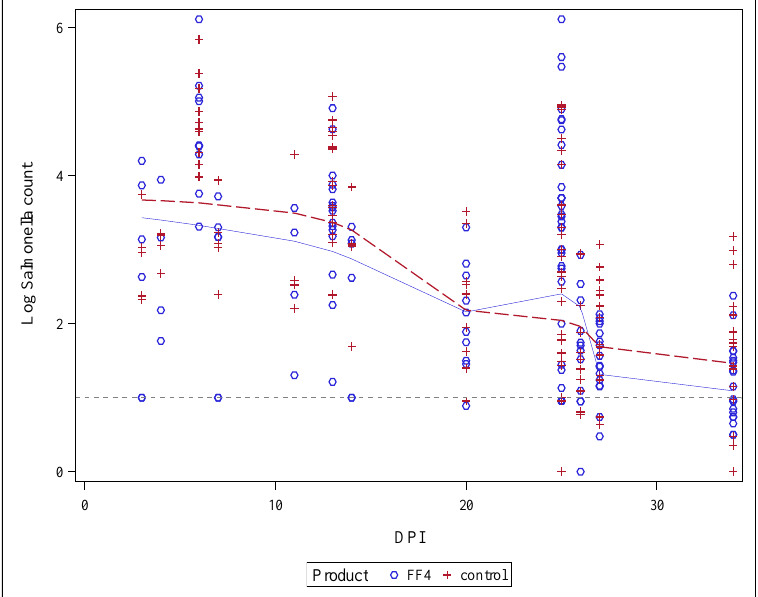
Figure 1. Individual Salmonella counts (log CFU/g) on different days post-inoculation (DPI). Each plus or circle represents one measurement per pen of the control or synergistic blend group respec- tively. The solid blue line is fitted through the data of the synergistic blend group, the dotted red line is fitted through the data of the control group. The vertical line represents where the split was made in the data set at 14 DPI.